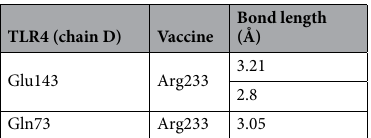
Table 7. List of amino acids involved in hydrogen bonds between vaccine and TLR4 (chain D).